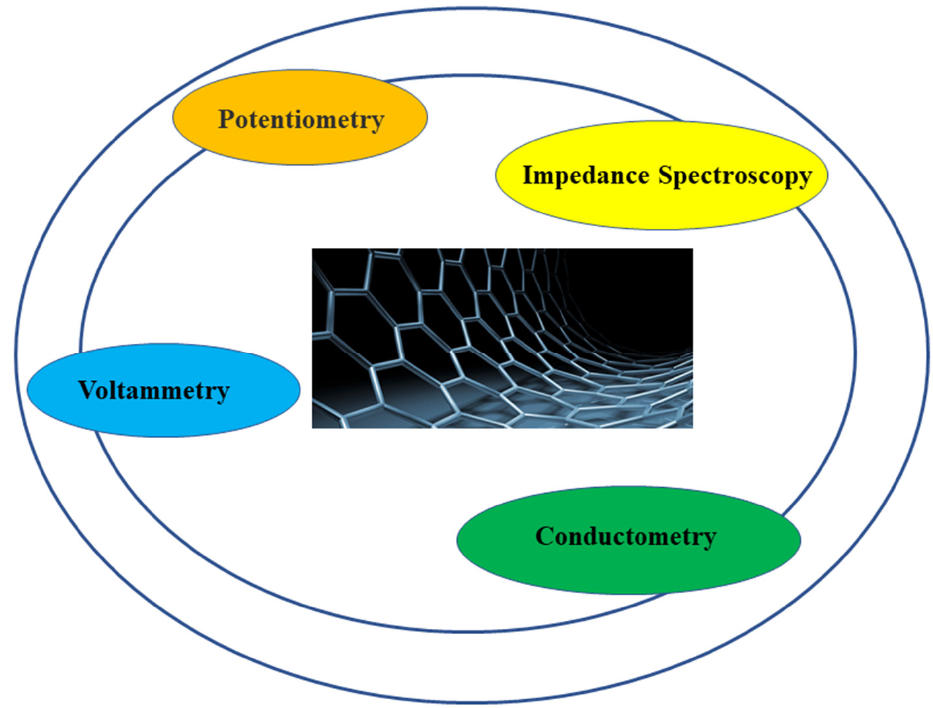
Figure 7. Scheme showing the applications of graphene in different sensor streams.